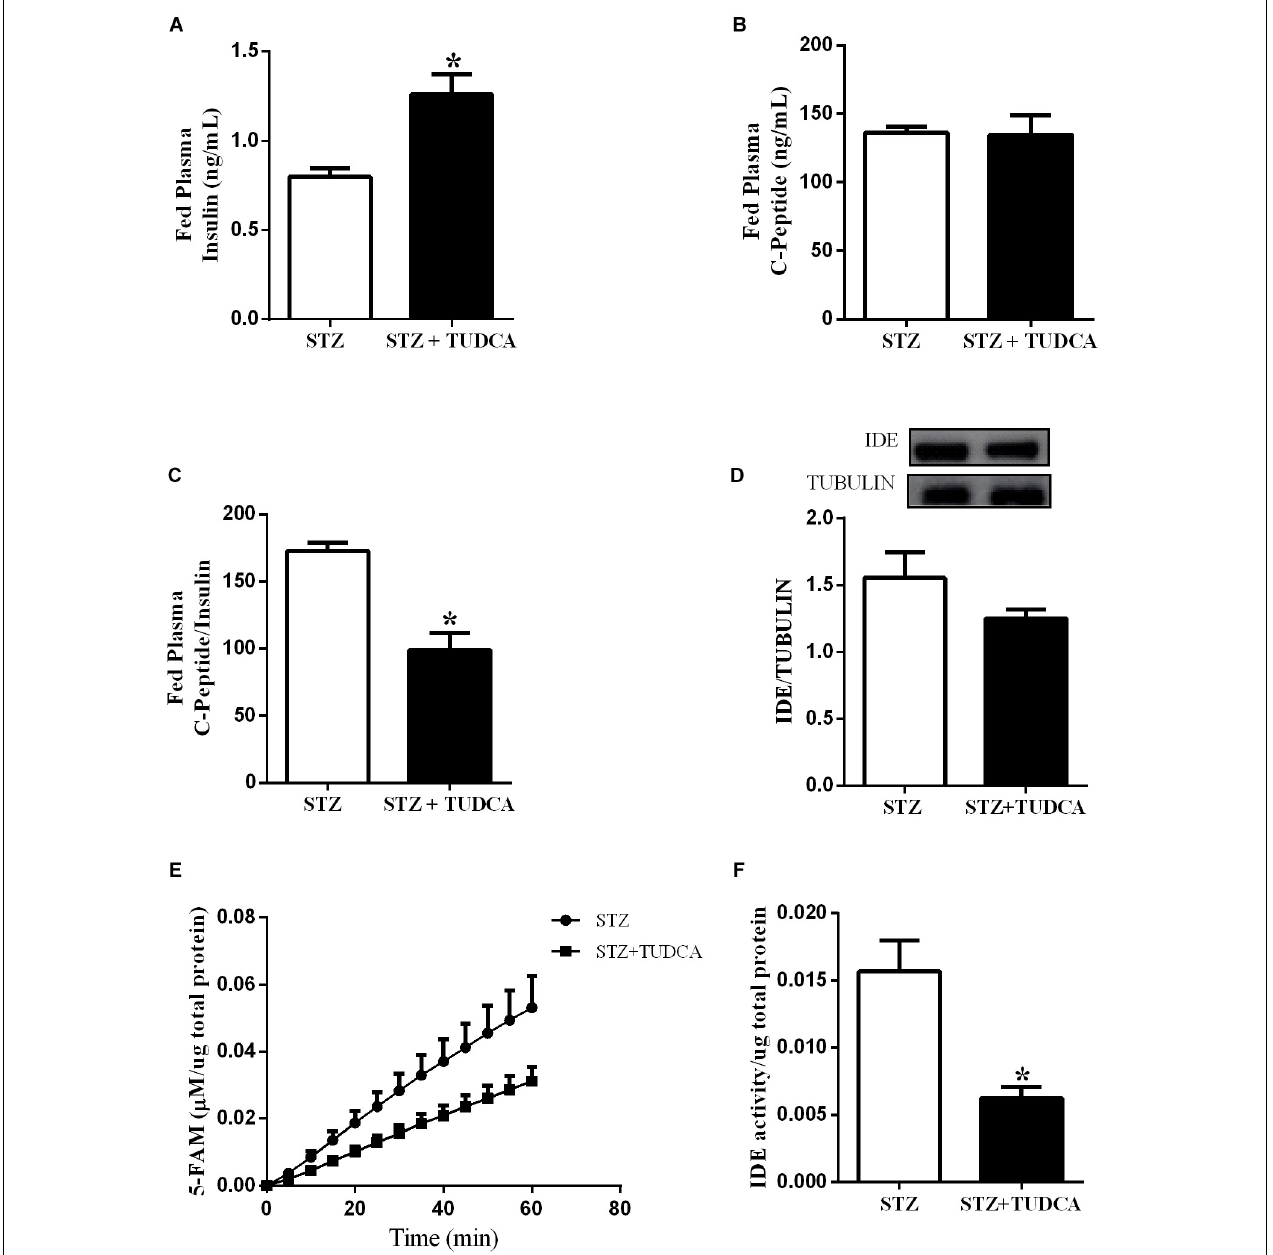
FIGURE 4 | TUDCA reduces insulin clearance and Insulin Degrading Enzyme (IDE) activity, but not IDE expression, in the liver of STZ mice. Plasma insulin of STZ (white bar, n = 7) and STZ+TUDCA (black bar, n = 7) in fed state (A) . Plasma C-peptide of STZ (white bar, n = 7) and STZ+TUDCA (black bar, n = 7) in fed state (B) . C-peptide/insulin ratio of STZ (white bar, n = 7) and STZ+TUDCA (black bar, n = 7) in fed state (C) . Protein expression of IDE in the liver and its representative immunoblotting images of STZ (white bar, n = 8) and STZ+TUDCA (black bar, n = 8) (D) . Kinetic of IDE activity assay (E) and total IDE activity (F) in the liver of STZ (white bar, n = 4) and STZ+TUDCA (black bar, n = 5) mice. Fluorescent intensity at Ex/Em = 490/520 nm was recorded every 5 min for 60 min. 5-FAM concentration was calculated using a standard curve and normalized per µ g of total protein. Data are the mean ± SEM. ∗ P ≤ 0.05 (Student’s t -test or Mann-Whitney